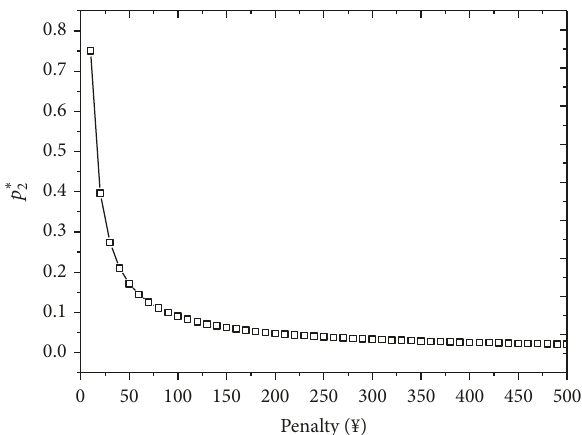
Figure 6: Influence of penalty on